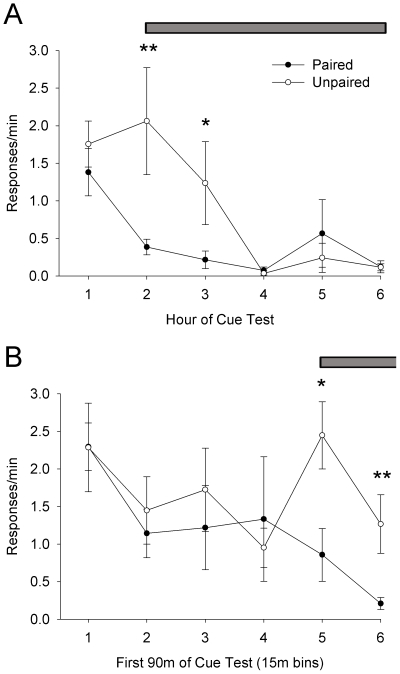
Cue-presentation test.A. Responses/minute of paired and unpaired animals over the six hour cue-presentation test. B. Responses/minute of paired and unpaired animals over the first ninety minutes of the cue-presentation test. Horizontal bars indicate period of variable 3–6 min interval SD tone presentations, variably presented every 3–6 min. N = 7 for both paired and unpaired groups.